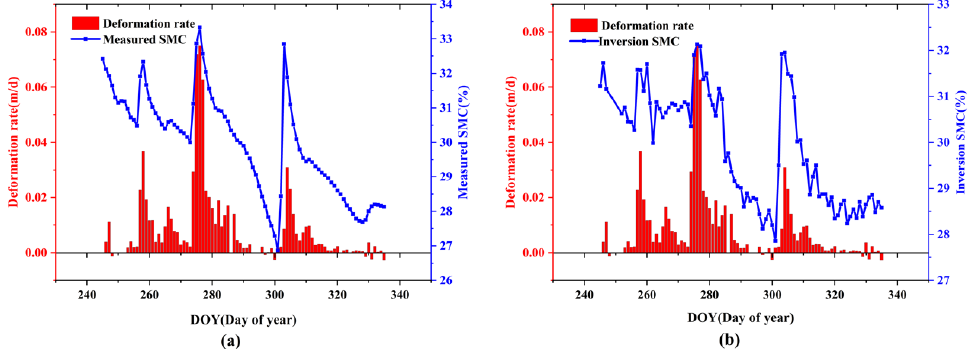
Figure 17. Relationship between soil moisture and deformation. Figure 18. Relationship between deformation rate and ( a ) measured soil moisture; ( b ) inverse soil moisture.